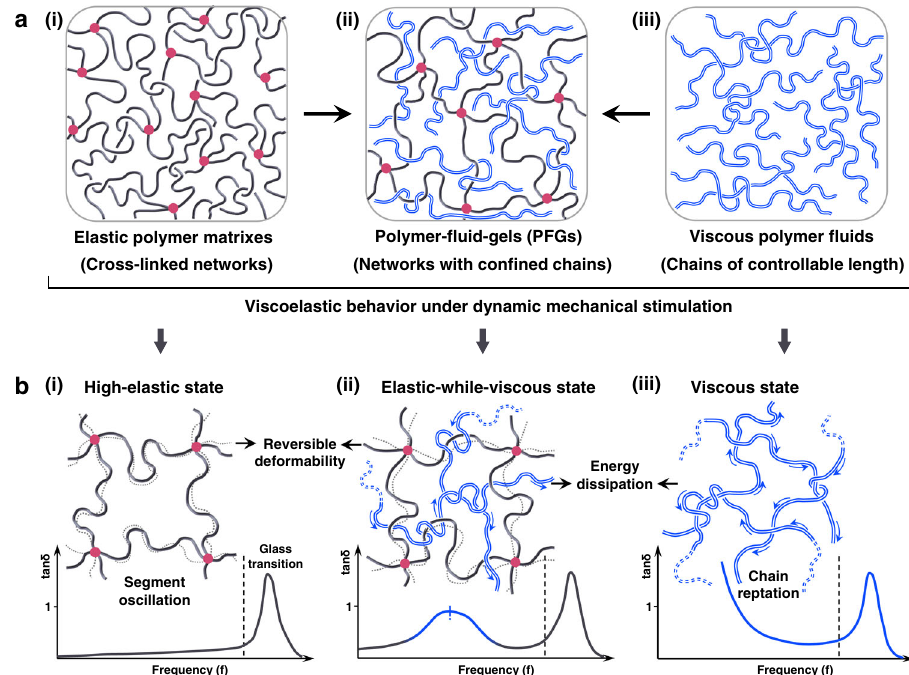
Fig. 1 Schematic structure of high energy-dissipation polymer- fl uid-gels (PFGs) design. a High energy-dissipation PFGs fabricated by introducing viscous polymer fl uids with controlled chain length into the elastic polymer networks. b Viscoelastic behavior of polymer networks, PFGs, and viscous polymer fl uids under dynamic mechanical stimulation. In the intermediate/low frequencies, polymer networks are in the high-elastic state where their chain segments are free to oscillate. They display considerably low energy dissipation (low tan δ ) and highly reversible deformability. In this case, polymer fl uids ’ energy dissipation (tan δ ) dramatically increases because of the whole chain reptation. The situation is quite different for PFGs. PFGs are in an elastic state, while viscous, where the whole chain reptation of con fi ned polymer fl uids can occur in the high-elastic region of the polymer network.